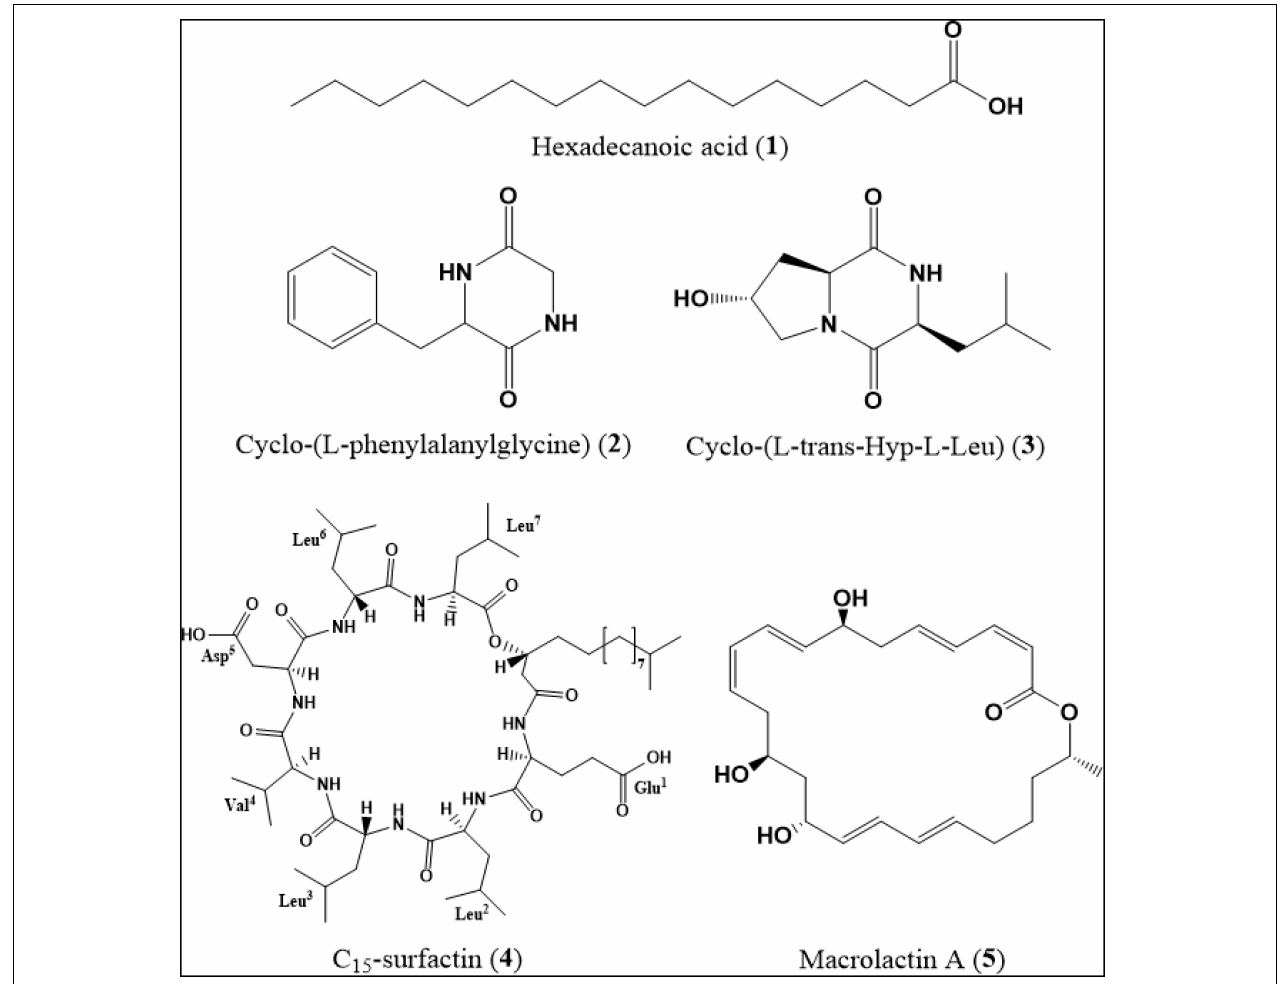
FIGURE 5 | Chemical structures of secondary metabolites ( 1–5